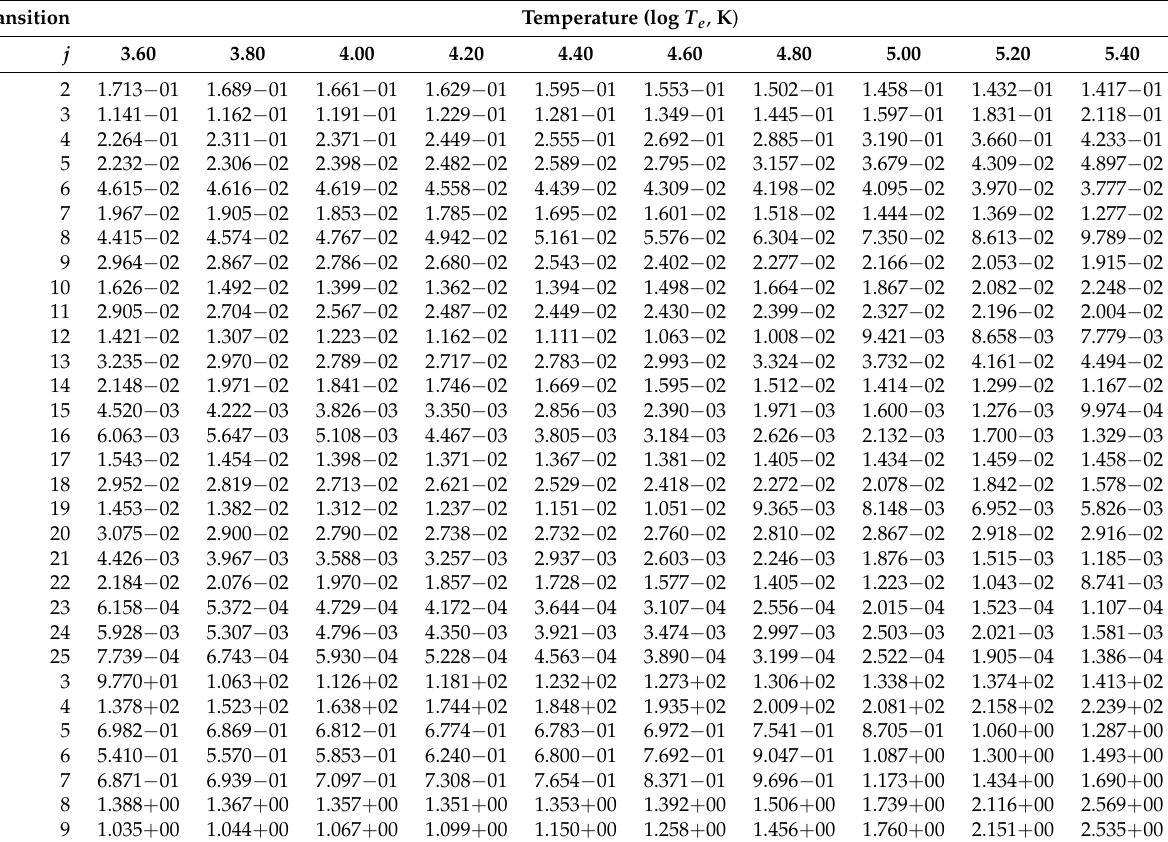
Table 4. Effective collision strengths for transitions in He II. ( a ± b ≡ a × 10 ± b